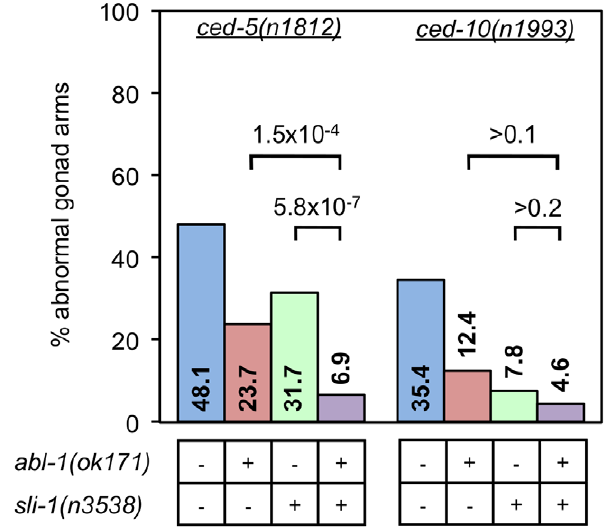
Figure 5. Losses of sli-1 and abl-1 enhance each other’s suppression of some engulfment gene DTC defects. The gonads of ced-5(n1812) and ced-10(n1993) young adult worms with and without mutations in abl-1(ok171) and/or sli-1(n3538) were scored for morphol- ogy using DIC microscopy. More than 80 gonad arms were scored for all genotypes. p values derived using Fisher’s exact test are shown.